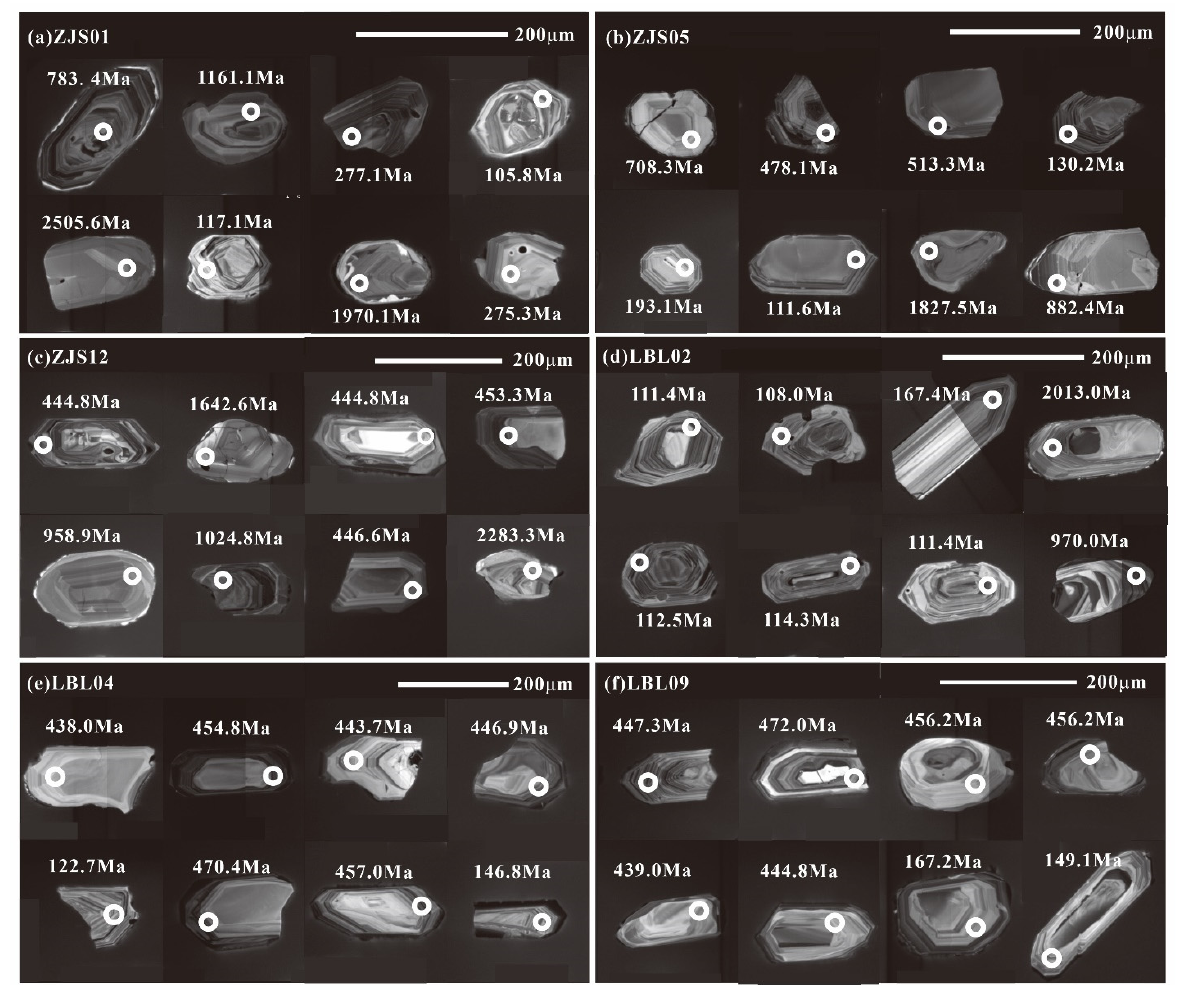
Figure 5. Representative cathodoluminescence images of detrital zircons of stream sediments in the Zijinshan Copper-Gold Orefield. The white circles represent the laser denudation spots of zircon U–Pb ages. ( a ) Stream sediment numbered ZJS01 around Zijinshan Cu-Au deposit; ( b ) Stream sediment numbered ZJS05 around Zijinshan Cu-Au deposit; ( c ) Stream sediment numbered ZJS12 around Zijinshan Cu-Au deposit; ( d ) Stream sediment numbered LBL02 around Luoboling Cu-Mo deposit; ( e ) Stream sediment numbered LBL04 around Luoboling Cu-Mo deposit; ( f ) Stream sediment numbered LBL09 around Luoboling Cu-Mo deposit.